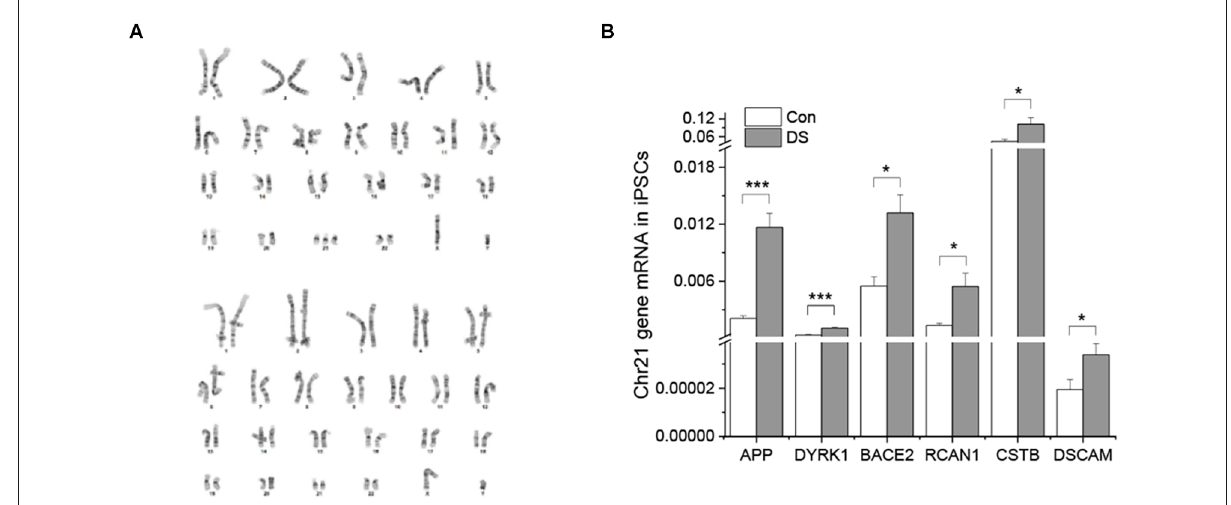
FIGURE1 Characterizations of DS iPSC and isogenic control cell lines. (A) DS iPSC (top) and isogenic control (bottom) lines have correct karyotypes. (B) Overexpression of chromosome 21 genes in DS iPSCs was confirmed by real time PCR ( n = 4). * p < 0.05 and *** p < 0.001 vs.